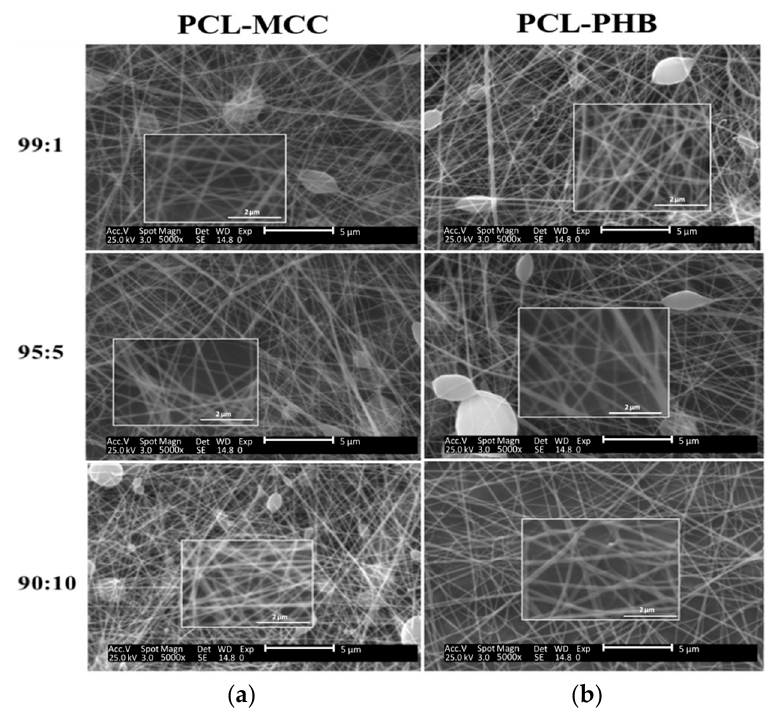
Figure 3. SEM images of ( a ) electrospun PCL-MCC mats and ( b ) PCL-PHB mats. Note: MCC = SEM images of ( a ) electrospun PCL-MCC mats and ( b ) PCL-PHB mats. Note: microcrystalline cellulose; PHB = poly(3-hydroxybutyrate) MCC = microcrystalline cellulose; PHB =